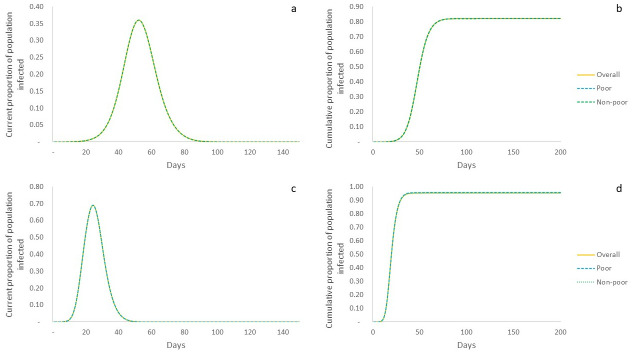
Simulated system outcomes in non-intervention scenario.Yellow line represents overall population; dashed blue line represents poor population; and dashed green line represents non-poor population. a: Current proportion of population infected over time on ER graph. Depicts the current infected caseload (as of each day) as a proportion of the population. All sections of the population contribute proportionally to caseloads. b: Cumulative proportion of population infected over time in ER graph. Depicts the temporal evolution of cumulative populations infected. All sections of the population display the same trend in cumulative infection rates. c: Current proportion of population infected over time in BA graph. Shows exponential growth and decay with a much higher peak than in the ER graph. d: Cumulative proportion of population infected over time in BA graph. Fractions of population affected are exactly the same across poor and non-poor categories, though much higher than in ER graph. Overall, in this non-intervention scenario, both categories of the population are similarly affected, per expectation, across all network types.